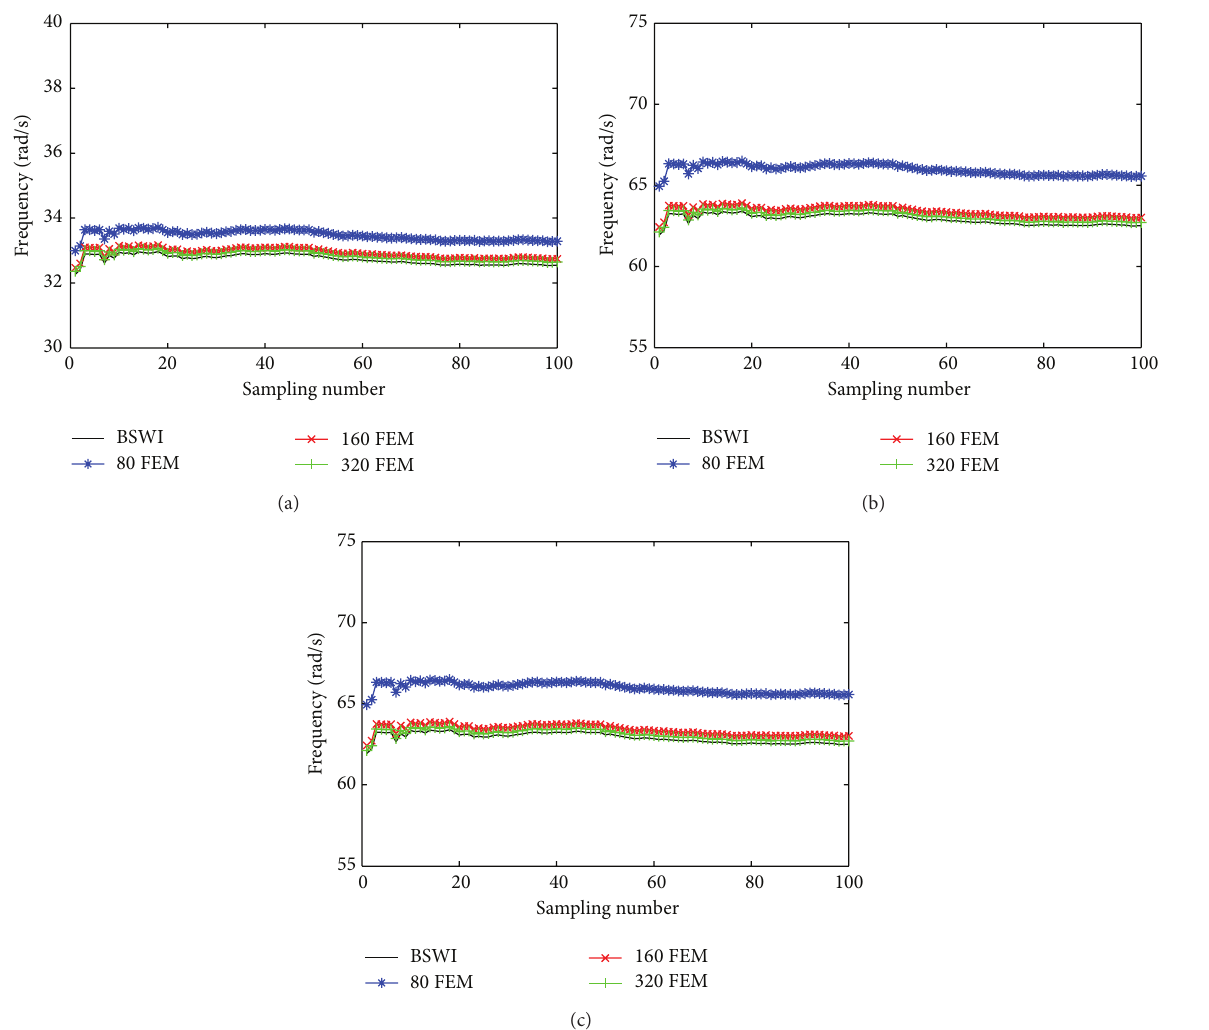
Figure 14: Relationship between the first three natural frequencies and sampling numbers of the Mindlin plate. (a) First-order circular frequency, (b) second-order circular frequency, and (c) third-order circular frequency.